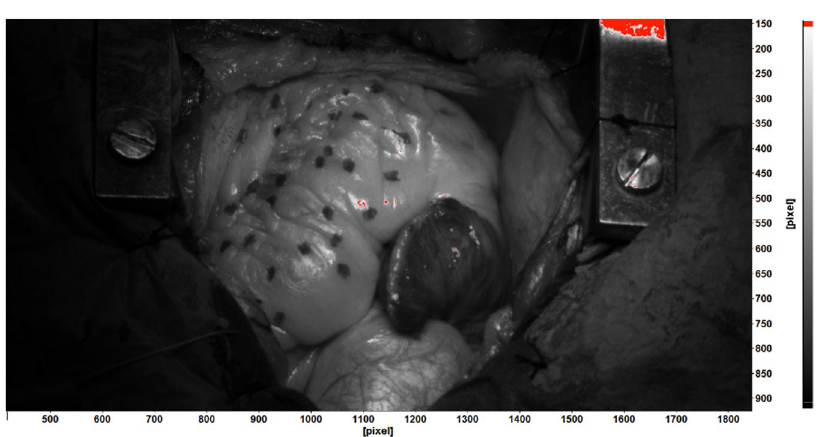
Figure 2. An example of the pattern applied by the surgeons during the surgery using a non-toxic sterile